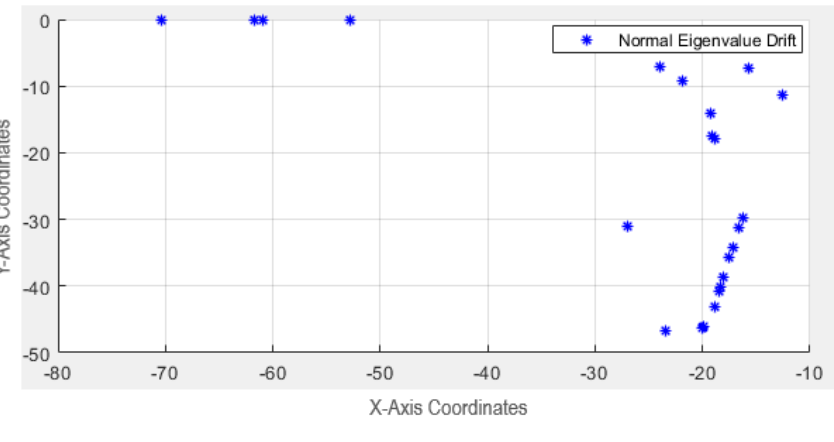
Figure 13. Baseline eigenvalues.